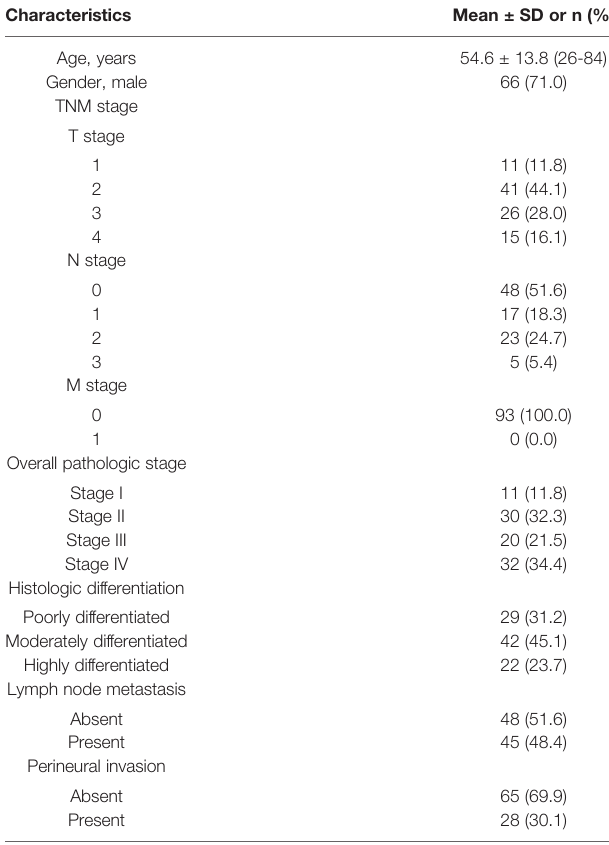
TABLE 1 | The clinicopathologic characteristics of patients with OTSCC (n = 93).